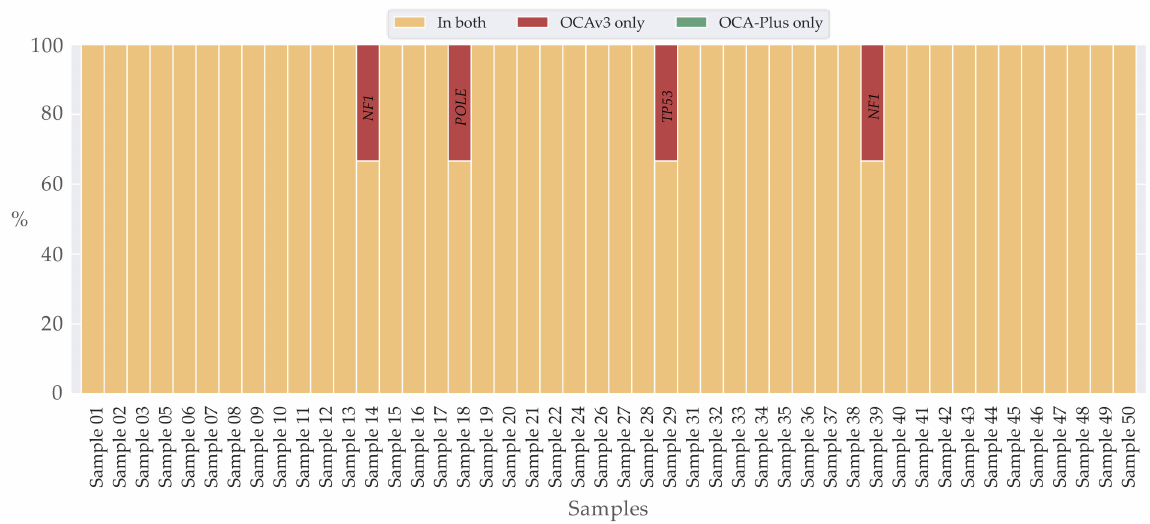
Figure 5. Overlap of identified variants in OCAv3 and OCA-Plus of clinical relevance. Stacked bar-chart of percentual overlapping locus variants of OCAv3 and OCA-Plus per samples; 42/46 samples overlapped completely, 4/46 showed difference in locus variants, hence only identified in